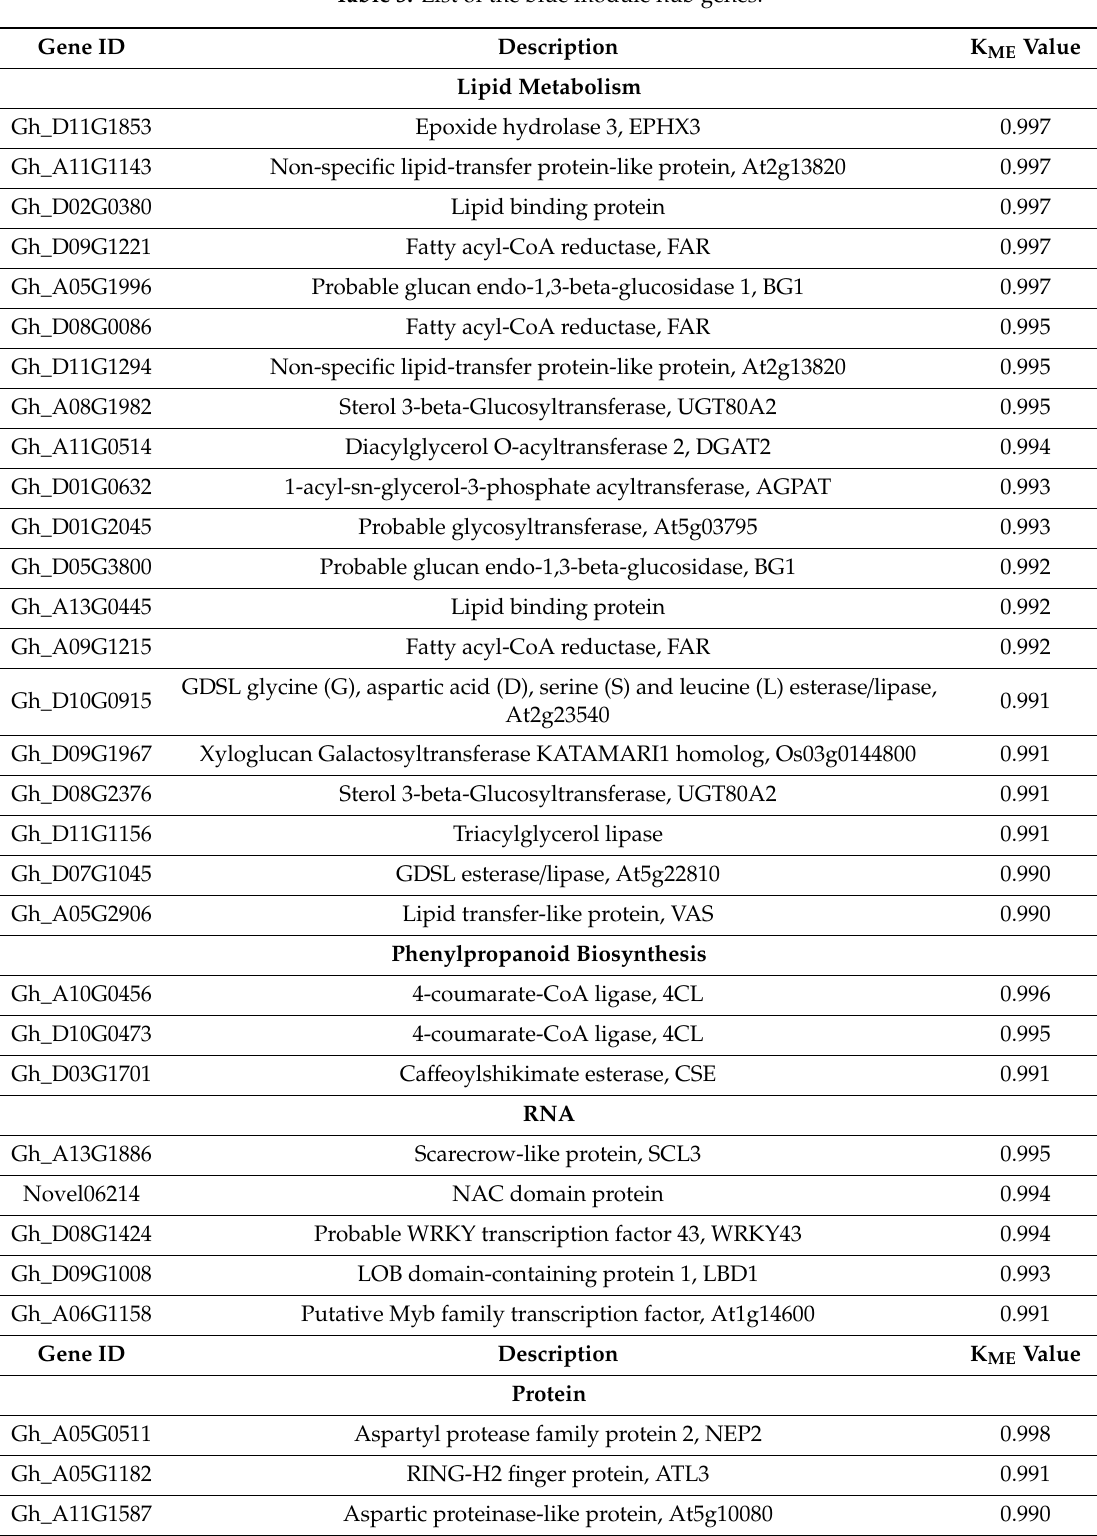
Table 3. List of the blue module hub